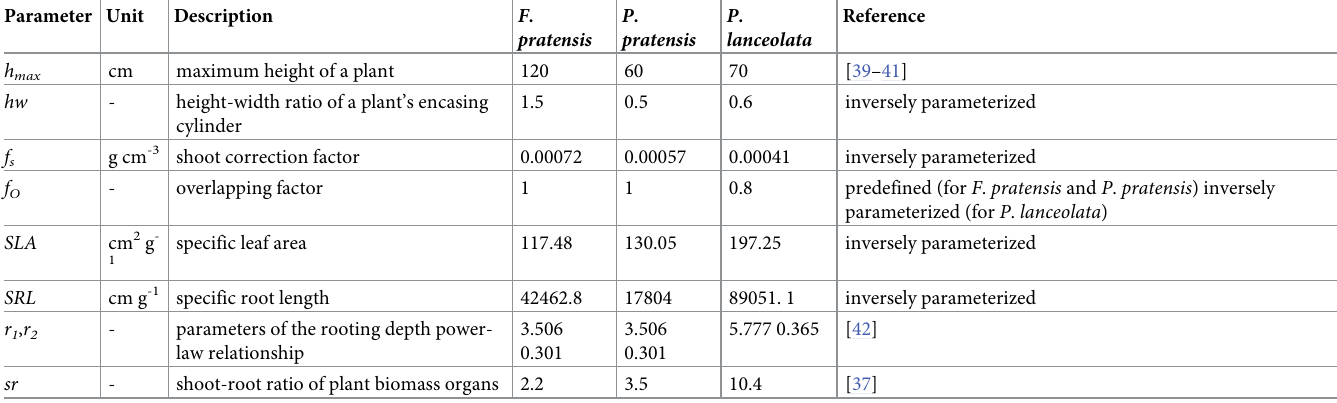
Table 1. Geometrical parameters for the three species.